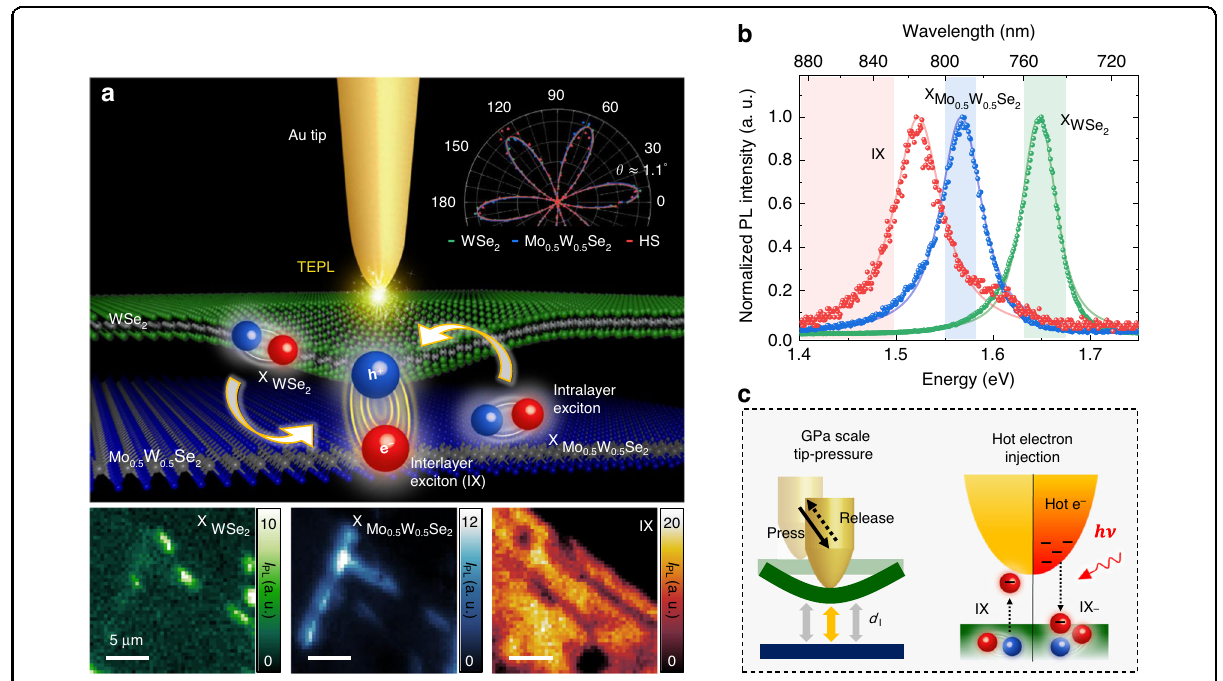
Fig. 1 Schematic of multifunctional tip-enhanced photoluminescence spectroscopy to dynamically control excitonic processes in TMD heterobilayer. a (Top) Illustration of the WSe 2 /Mo 0.5 W 0.5 Se 2 heterobilayer with SHG polarization dependence and the Au tip to probe and control the crystal. (Bottom) Hyperspectral confocal PL images of the heterobilayer for the integrated intensities 740 – 760 nm (Green, X WSe (Blue, X Mo ), and 830 – 900 nm (Red, IX). Scale bars are 5 μ m. b Normalized far- fi eld PL spectra of IX, X Mo 0 : 5 W 0 : 5 Se 2 colored regions are spectral regions used for hyperspectral images in ( a ), respectively. c Schematic diagram describing the multifunction of TEPL spectroscopy to dynamically control the intralayer- and interlayer-excitonic properties, such as interlayer coupling strength and interlayer trion (IX − )